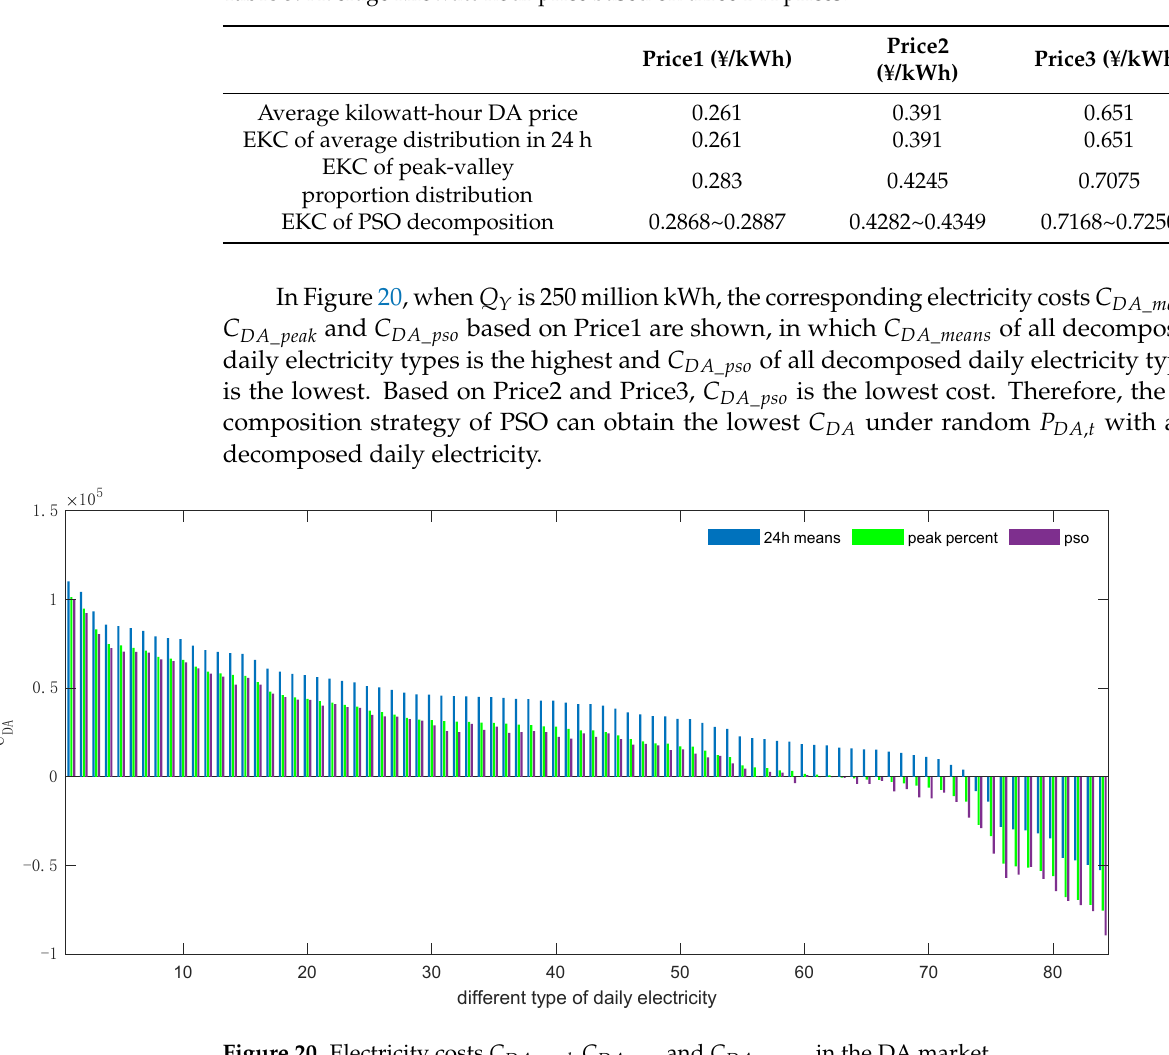
Table 5. Average kilowatt-hour price based on three DA prices.